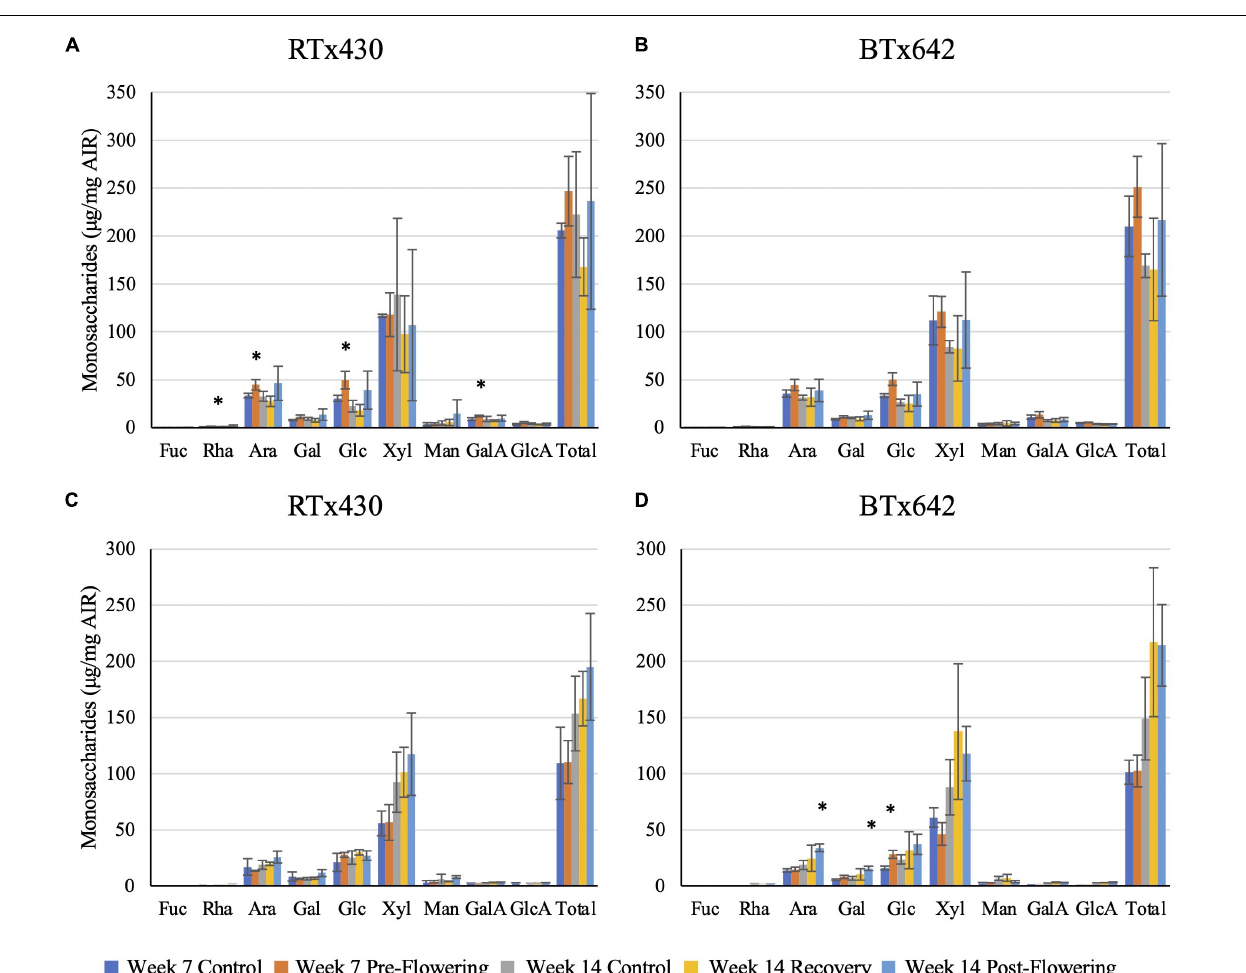
FIGURE 2 | Matrix monosaccharide composition analysis. Monosaccharides released from a trifluoroacetic acid (TFA) hydrolysis of the alcohol insoluble residue (AIR) from leaves (A,B) and roots (C,D) . Data represents mean ± SD of three biological replicates per condition per genotype where biological replicates themselves consist of 10 pooled plants from the same planting block. Asterisks indicate p < 0.05 determined by Student’s t -test with the Benjamini–Hochberg